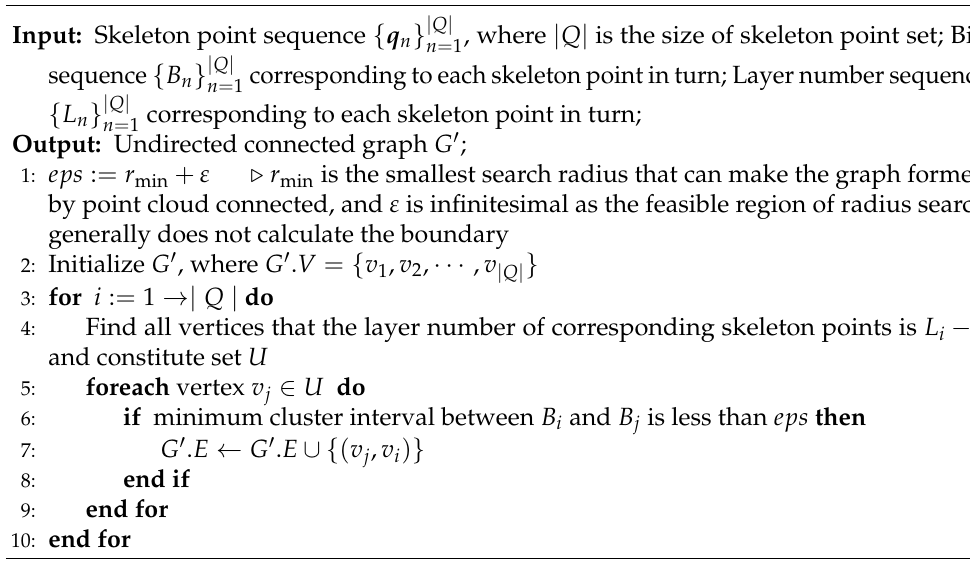
Algorithm 1 Graph formed according to hierarchical